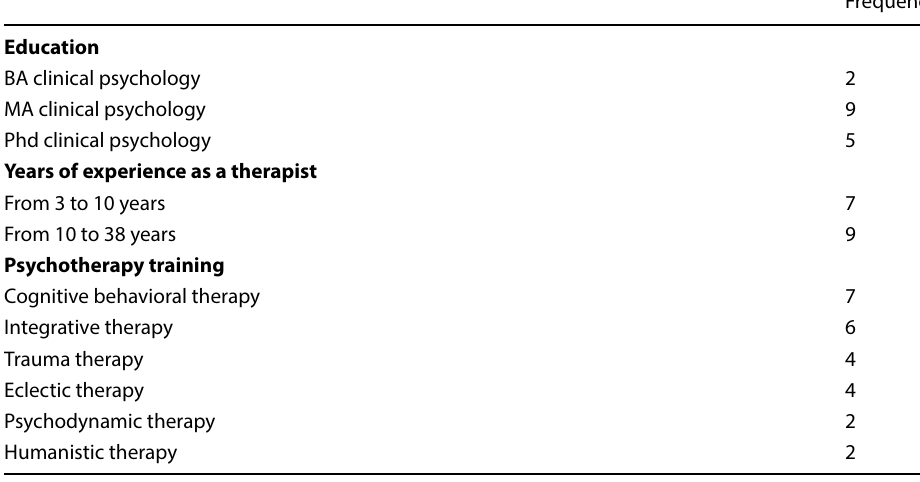
Table 1 Sociodemographic characteristics of